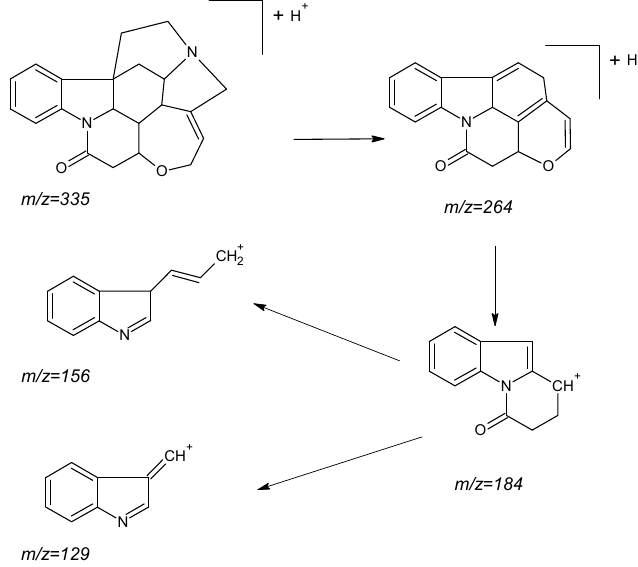
Figure 3. The proposed fragmentation path for strychnine.